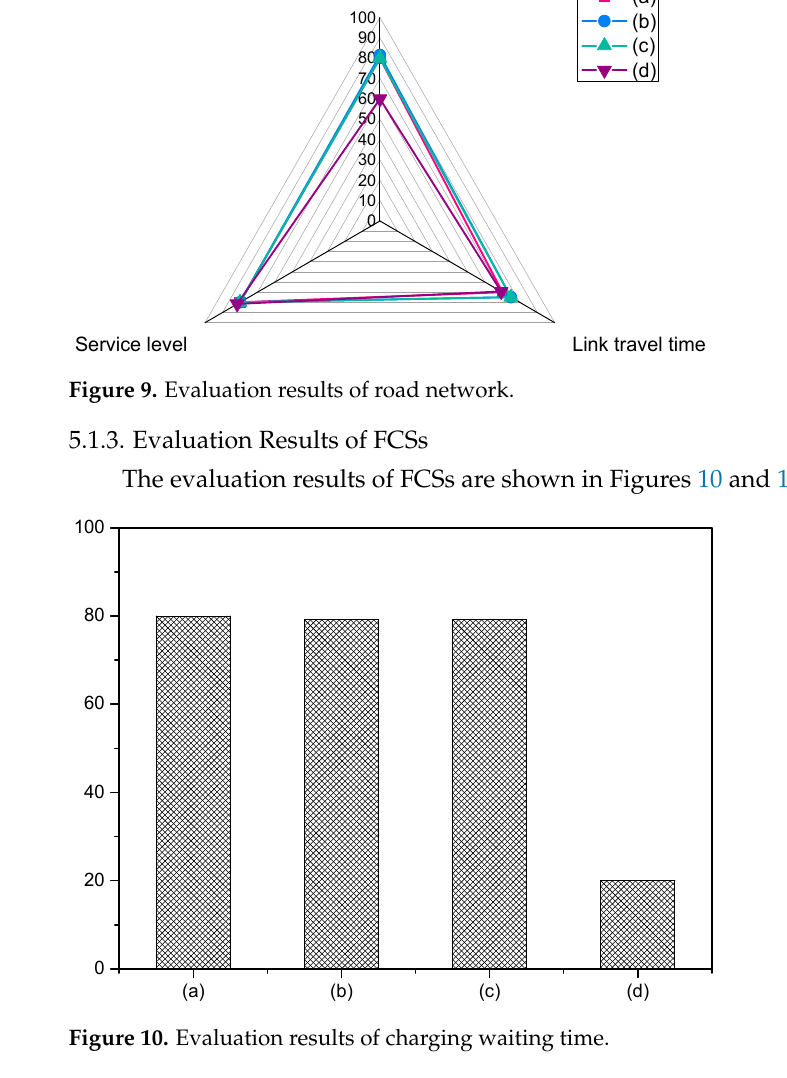
(a) (b) (c) (d) Figure 8. Evaluation results of distribution network. When the strategy (d) is applied to guide users, the power grid operation has obvious advantages over the other three guidance strategies. When the lowest charging price strat- egy is applied to guide EVs, EVs will be easy to guide to a single FCS, so the charging load connected to the distribution network is relatively small. The active load in the distribu- tion network is reduced and the active power loss is reduced. Since the charging price formulation process includes the penalty item of the voltage violation part, strategy (d)